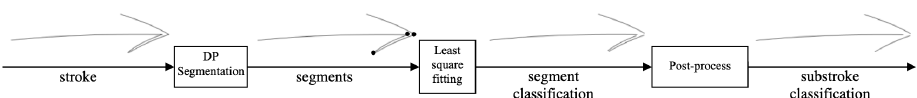
Figure 6. The three phases of the primitive shape recognition process.